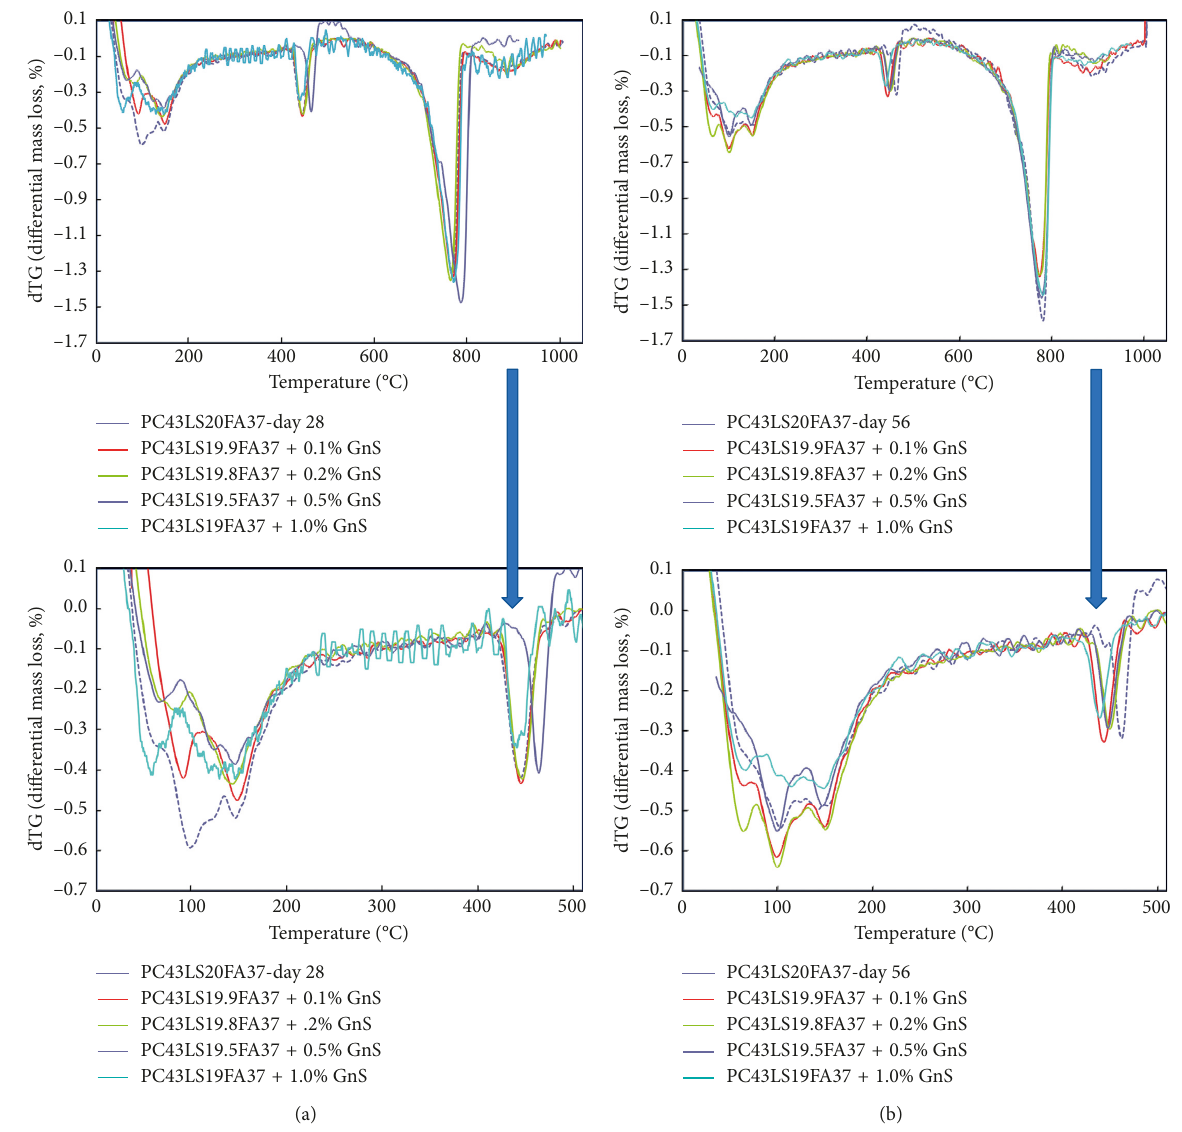
Figure 12: Differential mass loss of GnS nanocomposite binders based on PC43LS20FA37 at (a) day 28 and (b) day